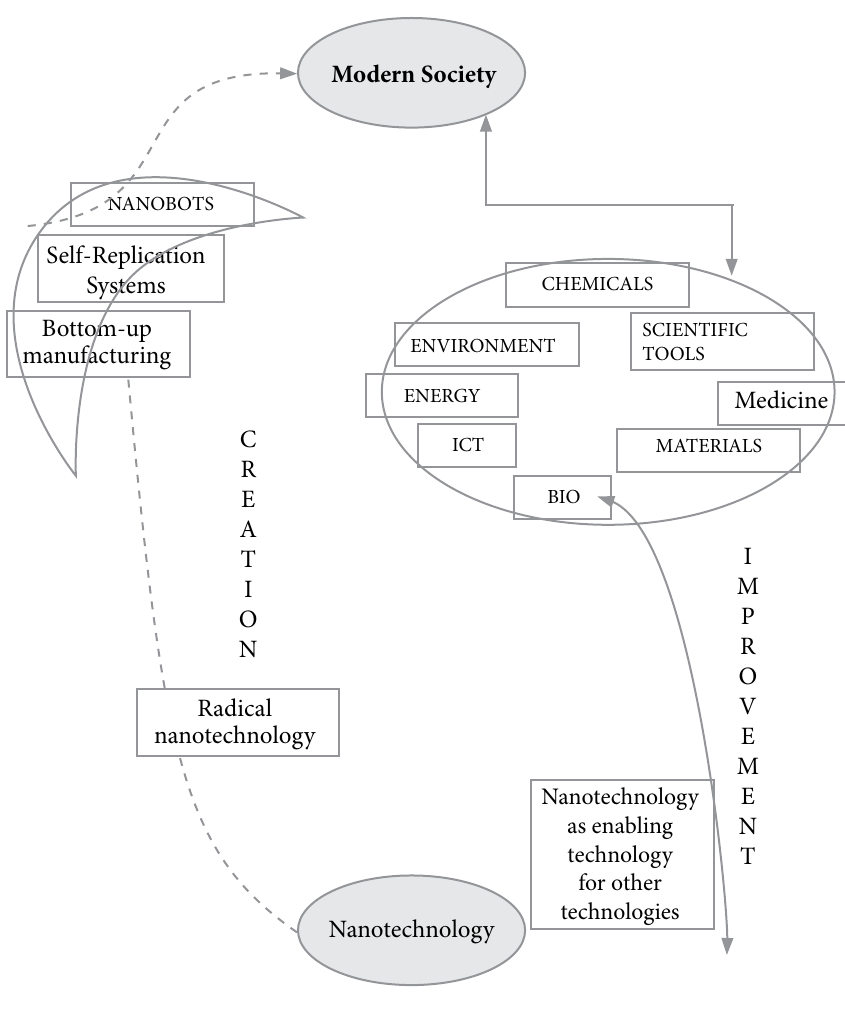
Nanotechnology as enabling technology for